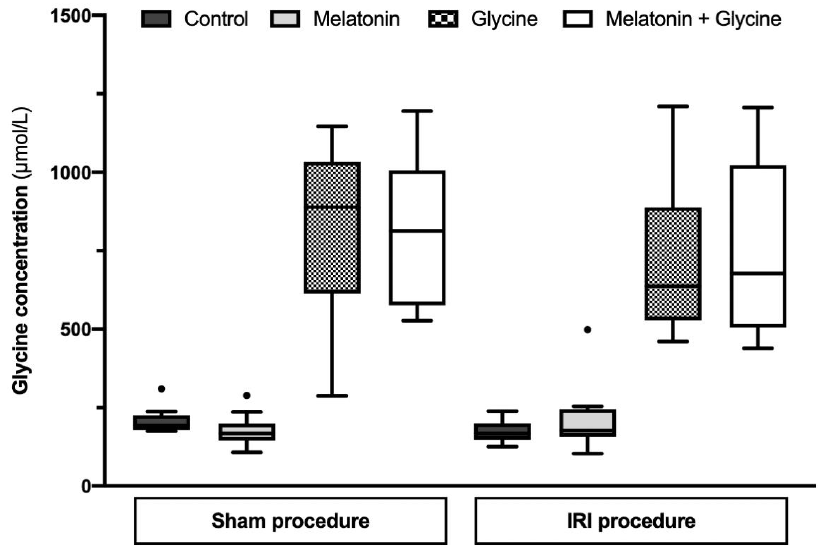
Figure 1. Glycine concentration in serum after 5 days of pretreatment in study groups. IRI: ische- mia/reperfusion injury. Data presented as median and interquartile range ( n = 10/group, except n = 9 in sham combined treatment group).